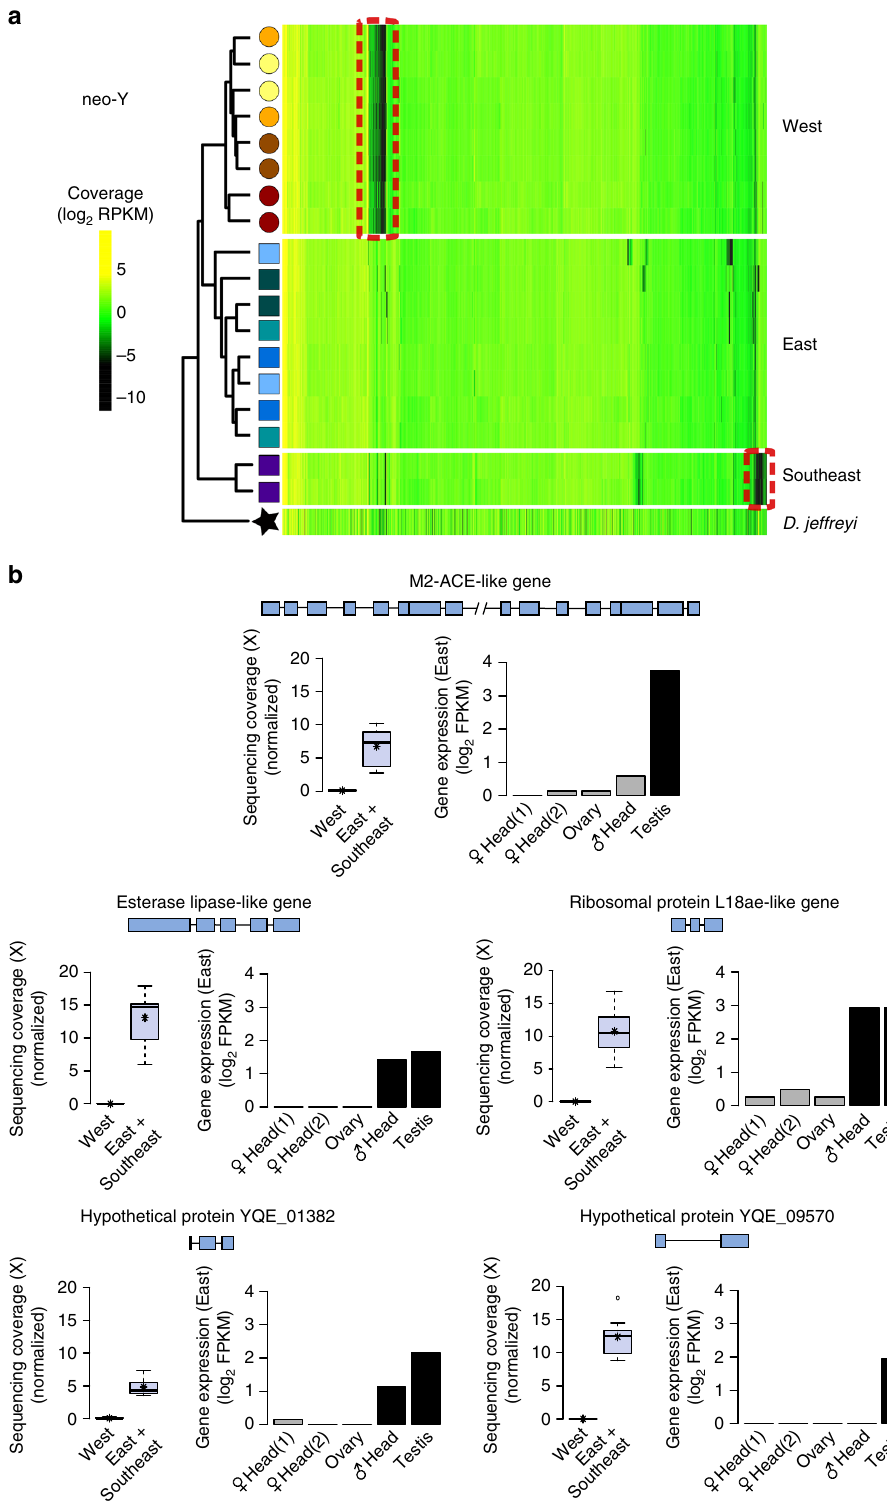
Fig. 5 Large-scale neo-Y deletions. a Clustered heatmaps of sequencing coverage of neo-Y scaffolds (columns) in individual males (rows). See Supplementary Fig. 9 for X and autosome partitions. Population symbols are as in Fig. 2a and clustered deletions indicated with red boxes. b At least fi ve genes were located within neo-Y deletions in West beetles. Normalized whole genome sequencing coverage and tissue expression pro fi le in East beetles are shown ( black bars ≥ 1 FPKM). See also Supplementary Table